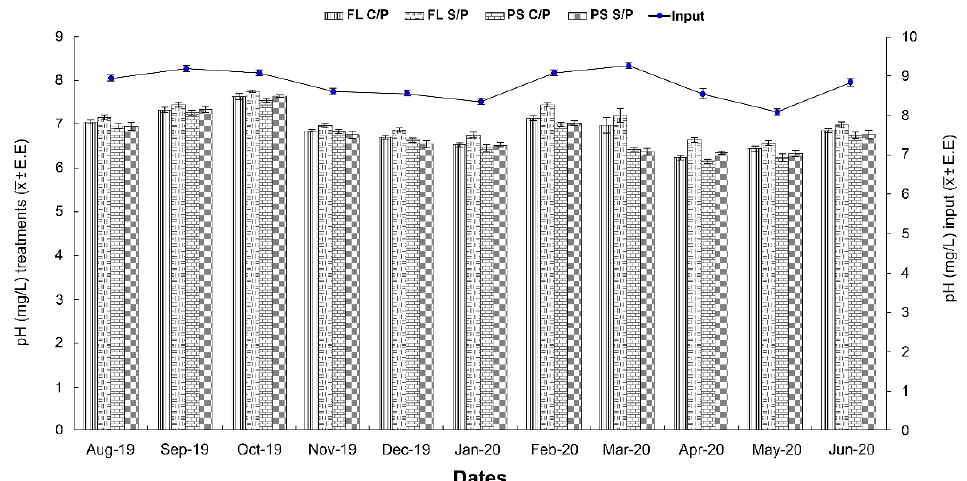
Figure 5. Average pH ( ± E.E.) values obtained during the experiment. (FLCP: free flow with plant; FLSP: free flow without plant; PSCP: saturated flow with plant; PSSP: saturated flow with plant; E.E.: standard error).